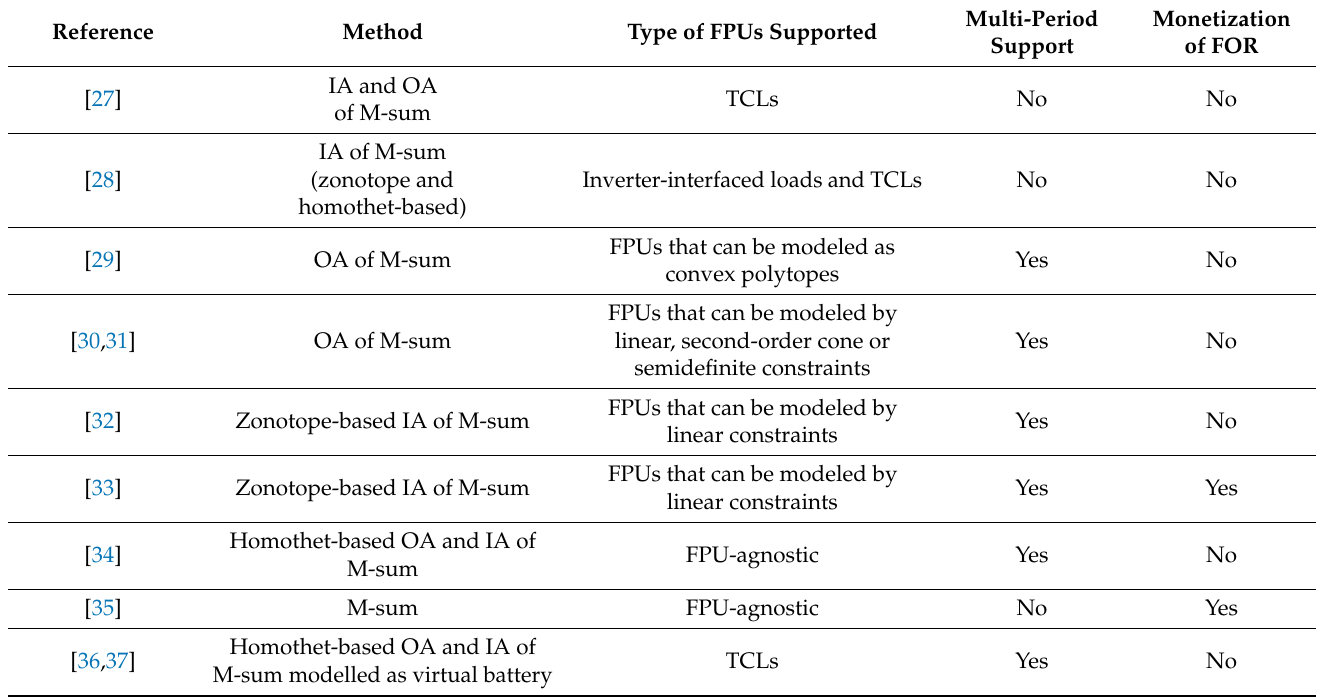
Table 2. A summary of the reviewed Geometric